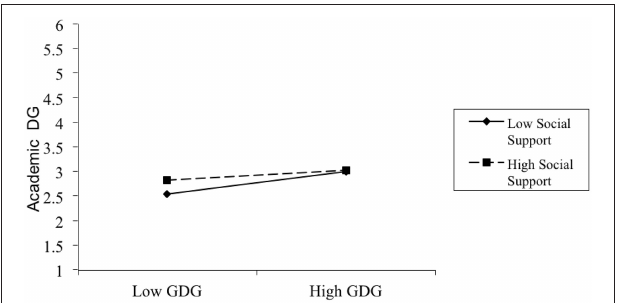
FIGURE 2 | Interaction between GDG and PSS on academic DG. Note: low = 1 SD below the mean; high = 1 SD above the mean.